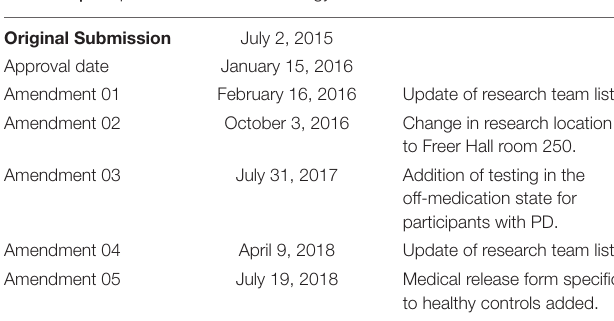
TABLE 8 | IRB protocol revision